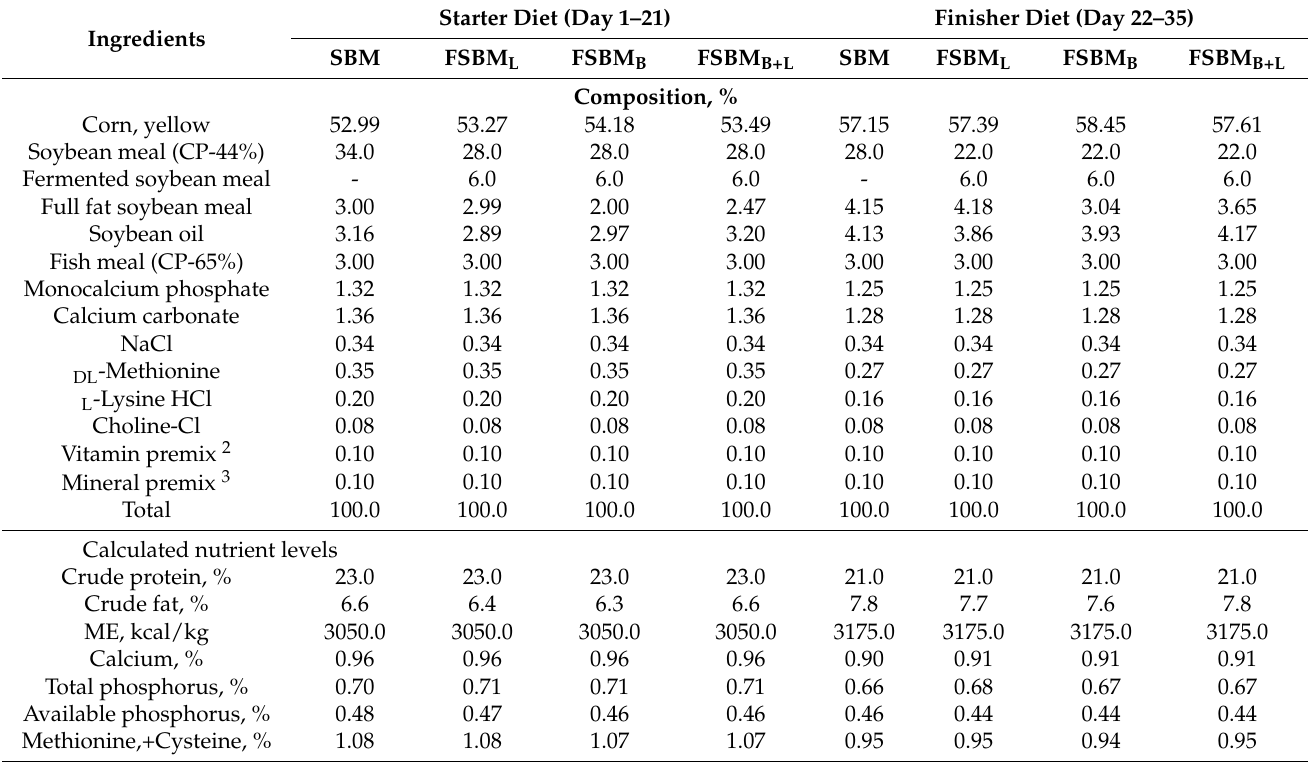
Table 2. Composition and calculated analysis (% as fed) of the basal diet for broilers (1–35 days) 1